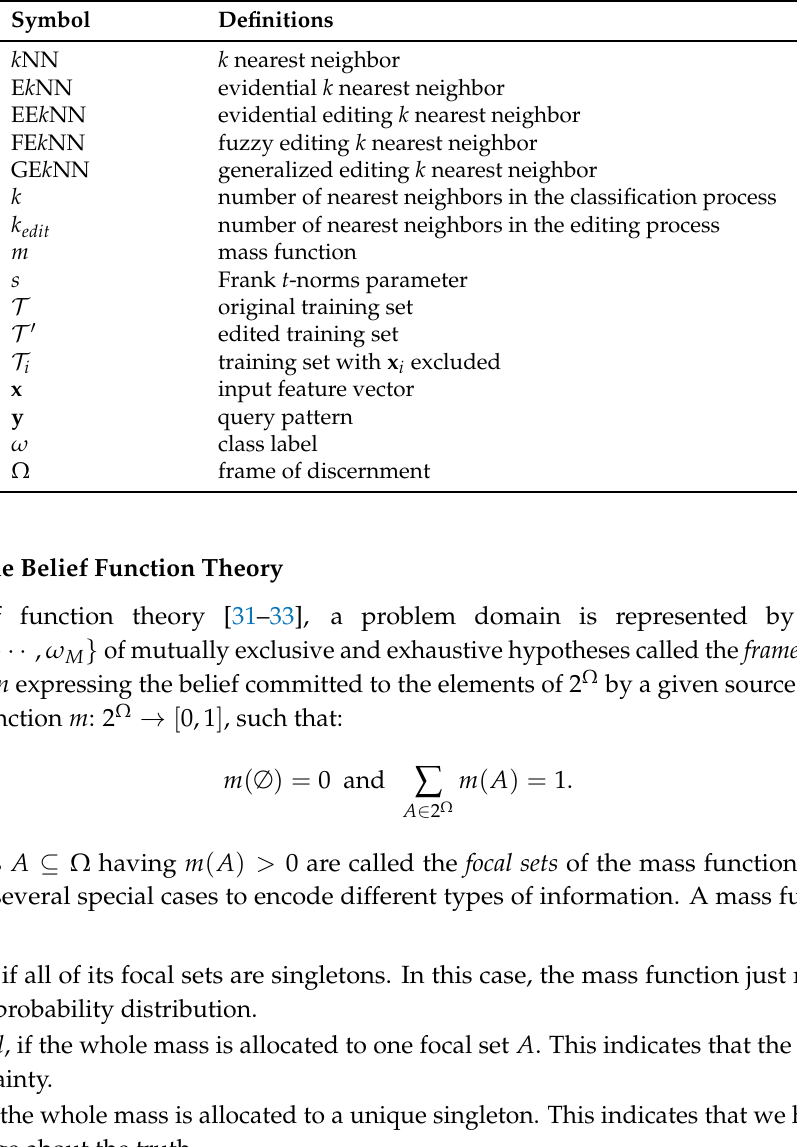
Table 1. List of symbols and